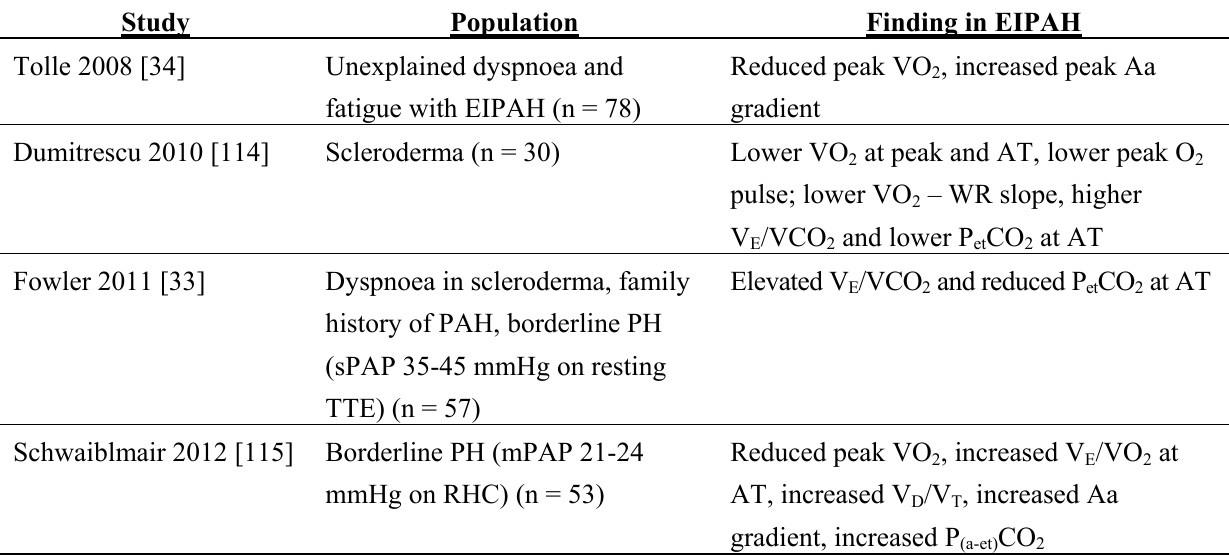
Table 3. Studies showing CPET variable abnormalities in exercise induced PAH